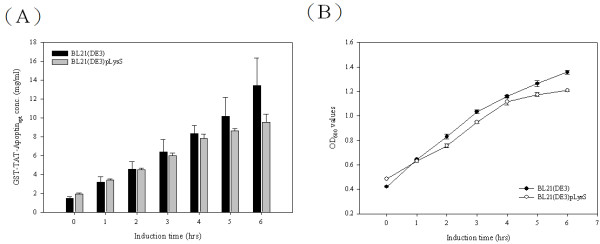
Productivities of TAT-Apoptinoptprotein and the growth curves in two recombinantE. colistrains. The productivities of GST-TAT-Apoptinopt using two E. coli strains, BL21(DE3) and BL21(DE3)pLysS containing pGEX-TAT-VP3opt are shown over time after IPTG induction at 25 °C (A). Growth curves of BL21(DE3) and BL21(DE3)pLysS expressing GST-TAT-Apoptinopt, respectively, in LB medium post-induction (B).